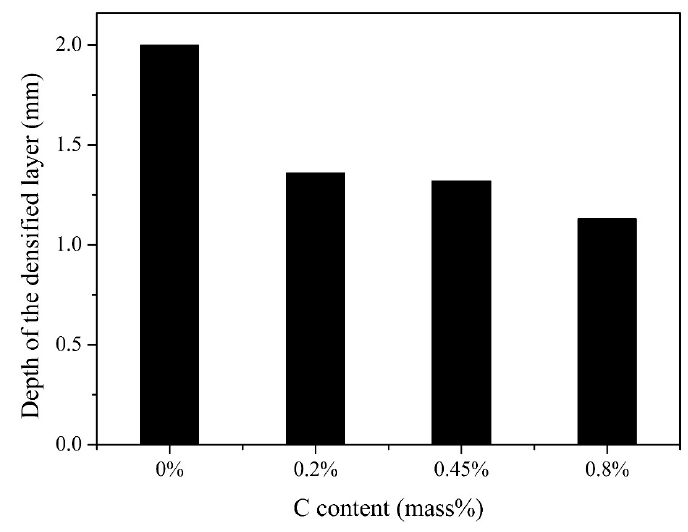
Figure 4. Comparison of depth of the densified layer.